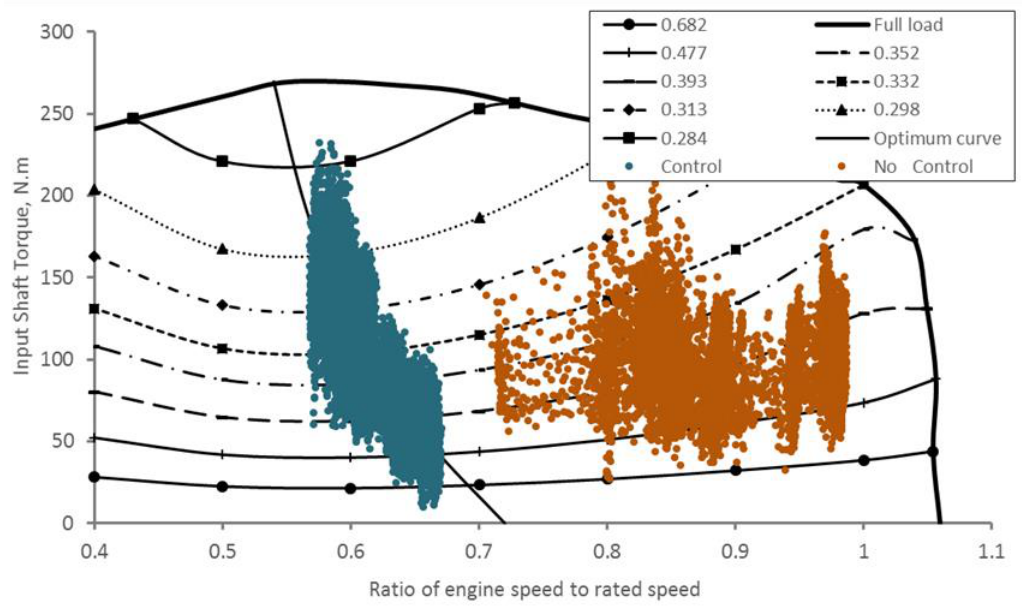
Figure 23. Engine operating region of plowing operations.